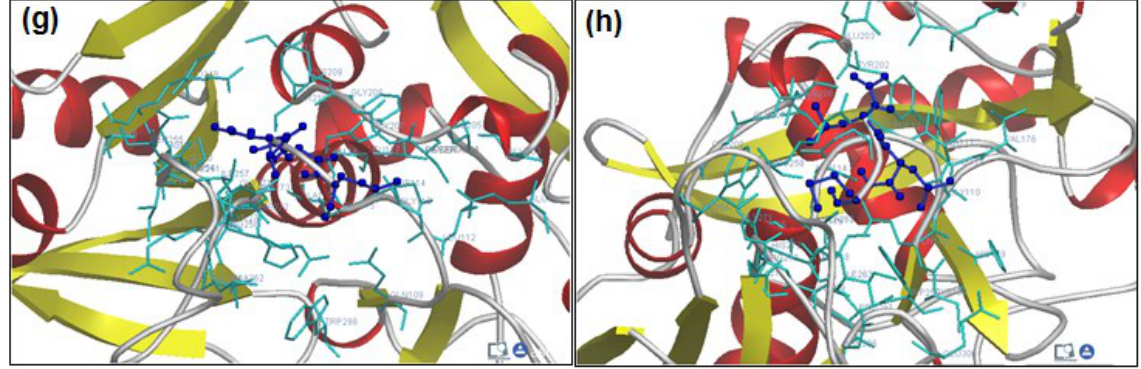
Figure 2. Visualization of the geometrical preferences of the calpain molecule (green secondary structure) in complexation with ligand molecules (yellow tube rendering). ( a ) Calpain inhibitor I (ALLN) and ( b ) calpain inhibitor II (ALLM) after